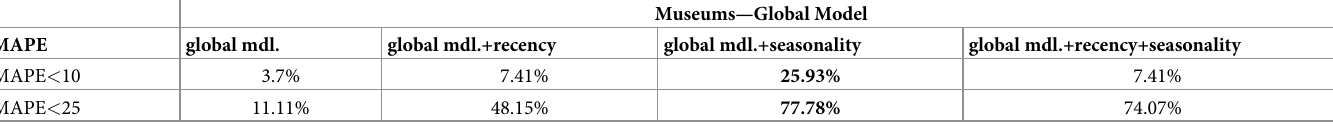
Museums—Global Model